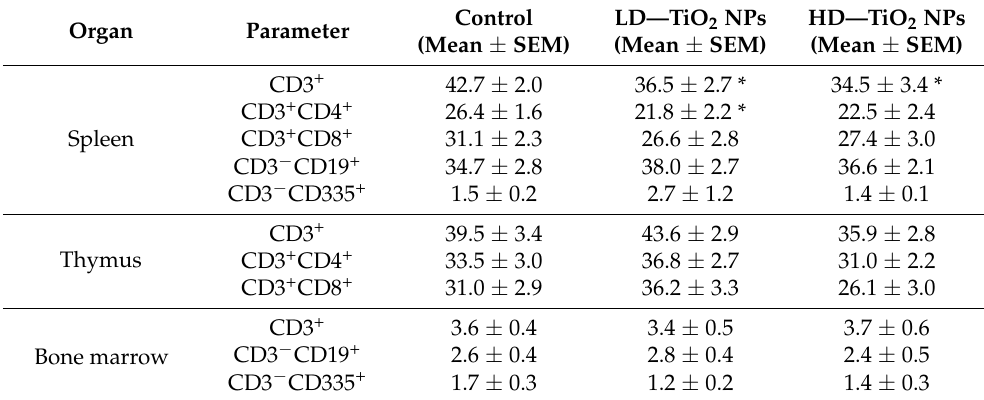
Table 1. Phenotypic analysis of spleen, thymus, and bone marrow. Organ Parameter